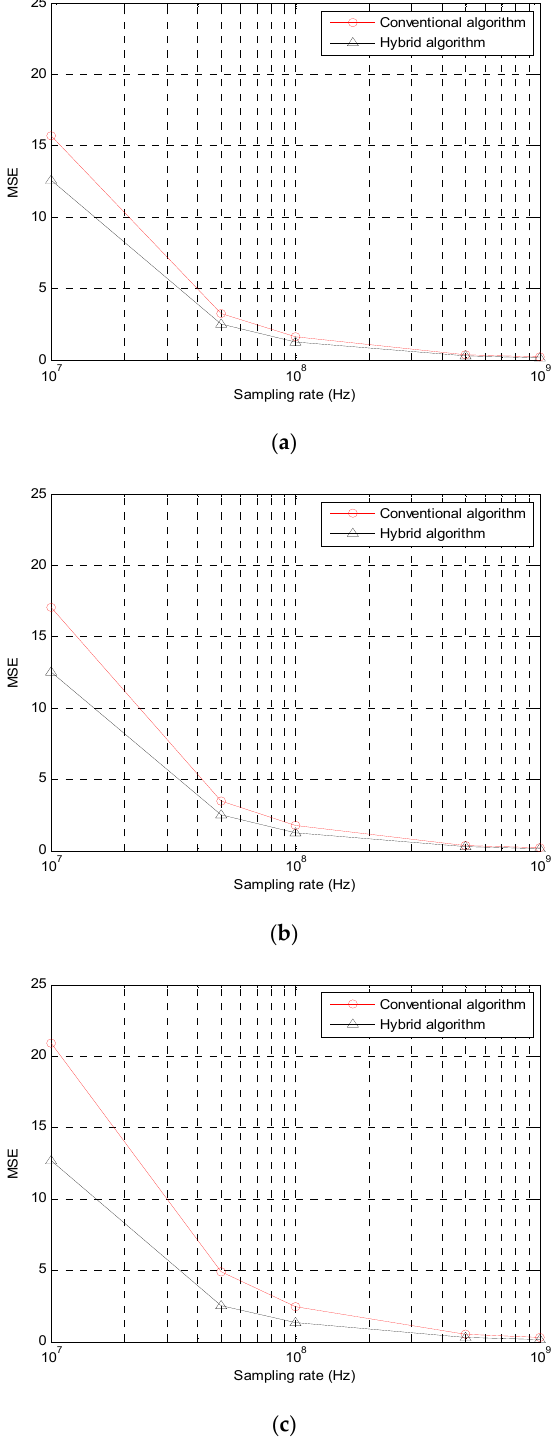
Figure 9. MSE curves for the estimated MS locations based on the proposed hybrid algorithm and the conventional algorithm, of the first scenario for ( a ) the first case, ( b ) the second case, and ( c ) the third case, for the first set.